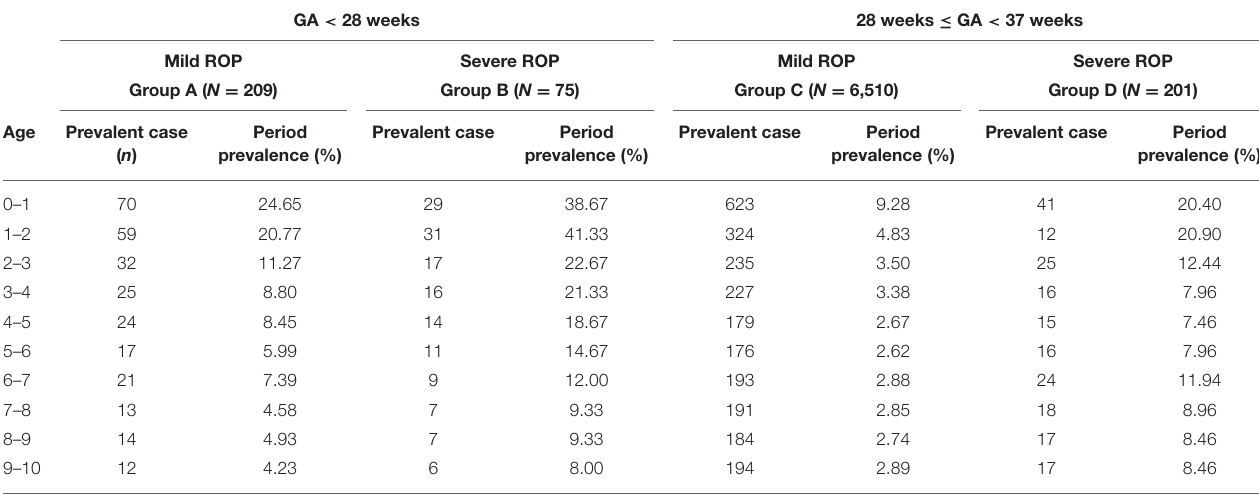
TABLE 1 | Annual prevalent number of cases and prevalence of overall neurodevelopmental complications among patients born between 2007 and 2008 with retinopathy of prematurity and treated, based on the KNHIS database throughout the 10-year follow-up